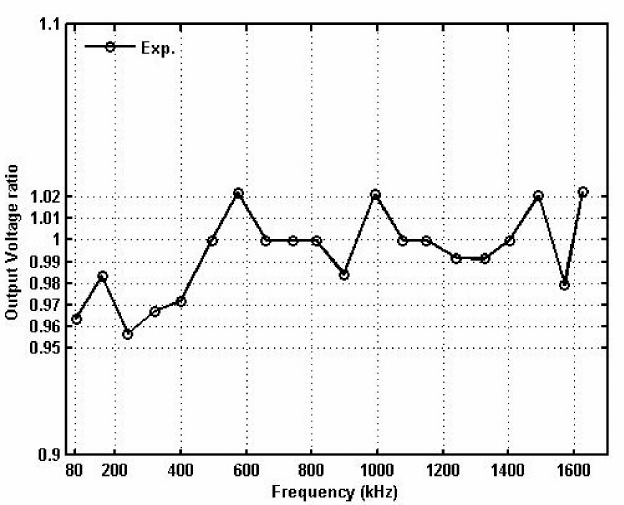
Figure 45. The measured amplitude ratio of quadrature output voltages V o4 and V o5 versus the tuning